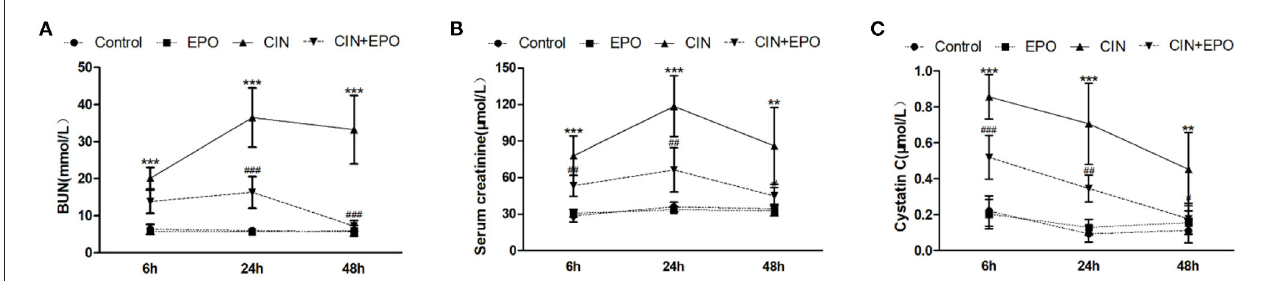
FIGURE 1 | Effect of EPO administration in renal functional parameters during CIN. (A) BUN (mmol/L), (B) serum creatinine ( µ mol/L), and (C) cystatin C ( µ mol/L). Values are the mean ± SD ( n = 6 mice/each group). ** P < 0.01 and *** P < 0.001 vs. the control groups; # P < 0.05, ## P < 0.01, and ### P < 0.001 vs. the CIN groups. BUN, blood urea nitrogen; EPO, erythropoietin; CIN, contrast-induced nephrology.